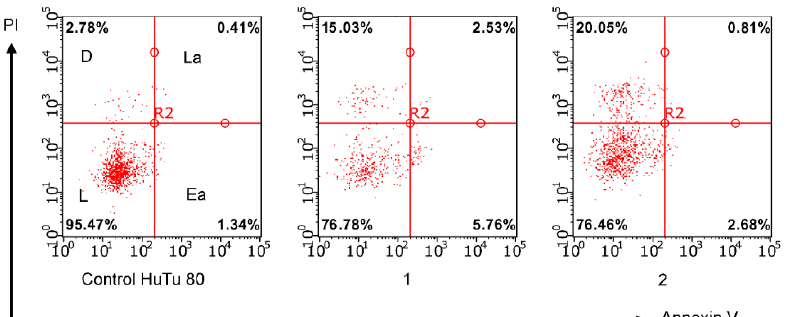
Figure 2. Apoptotic effects of compounds 2 а on HuTu 80 cells. 1 – 2 а at IC 50 /2 concentration (12.5 µM); 2 – 2 а at IC 50 concentration (25 µM).